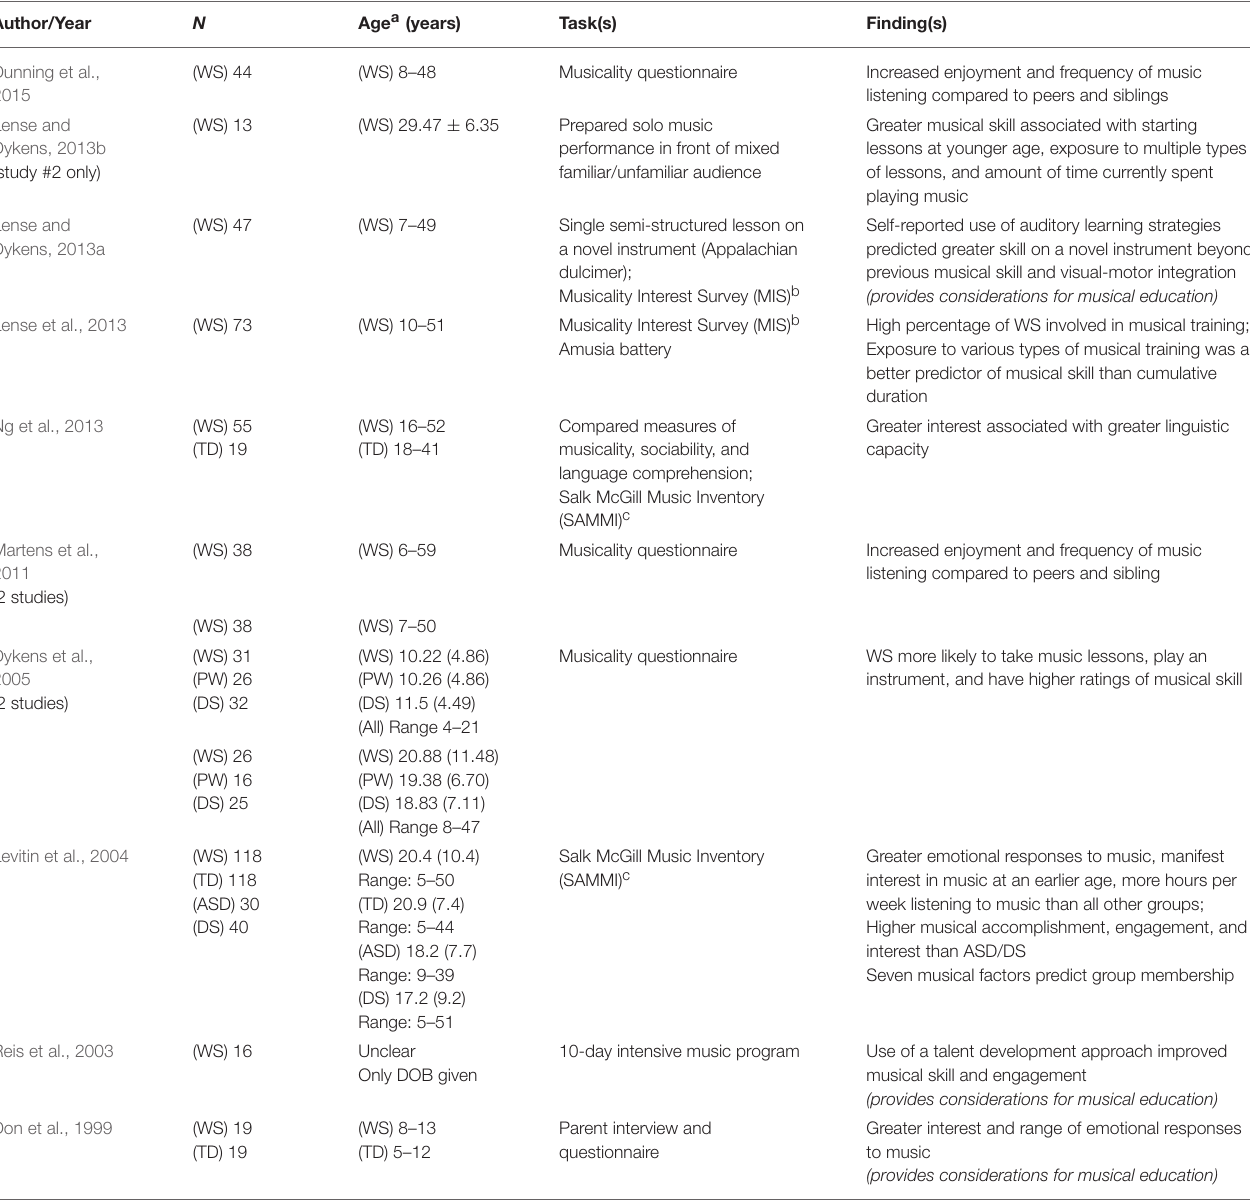
TABLE 2 | Musicality: affinity, experience, and